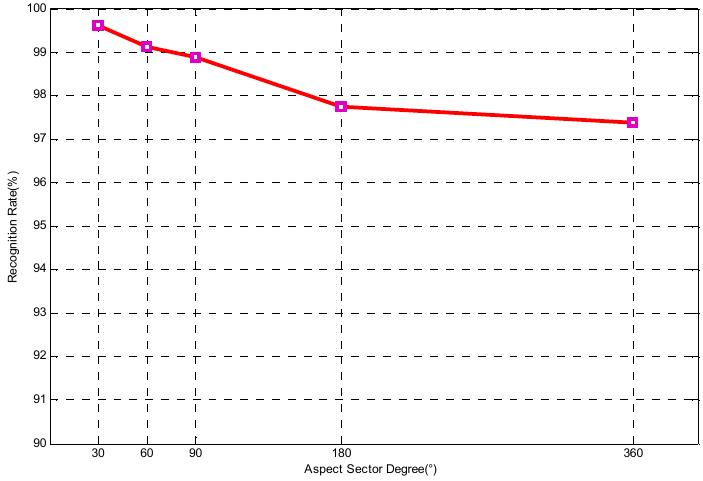
Figure 11. Variation in the performance of ADNNLS algorithm with the size of aspect sector.